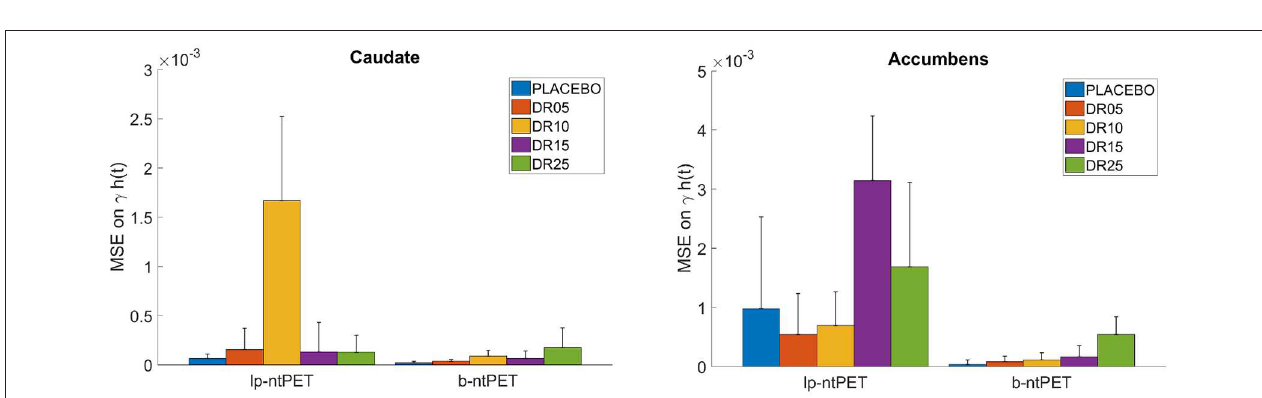
FIGURE 10 | Mean Squared Error (MSE) computed between each individual estimated release curve ( γ · h ( t )) and the reference estimated from the noiseless TACs, for each estimation method and condition. (Left) , caudate; (Right) , accumbens. Error bars show the standard deviations.